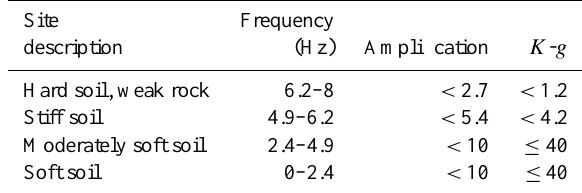
Table 6. Site effect classification based on the C – A